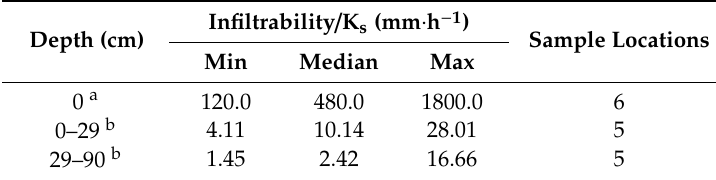
Table 1. Summary of infiltrability and saturated hydraulic conductivity (K s ). Data from the Retiro